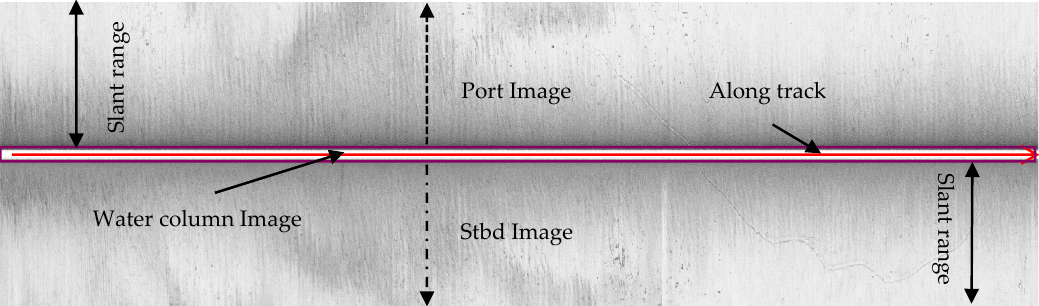
Figure 3. SSS waterfall image, it was measured in the South China Sea by Edgetech 4200 MP system.